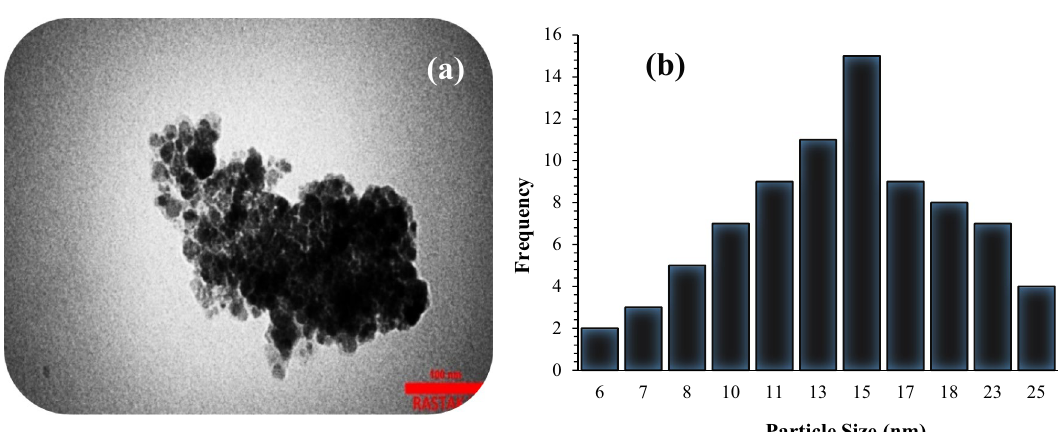
Figure 3. TEM images ( a ) Particle size distribution histogram ( b ) of the Fe 3 O 4 @Pectin@(CH 2 ) 3 -Acetamide-